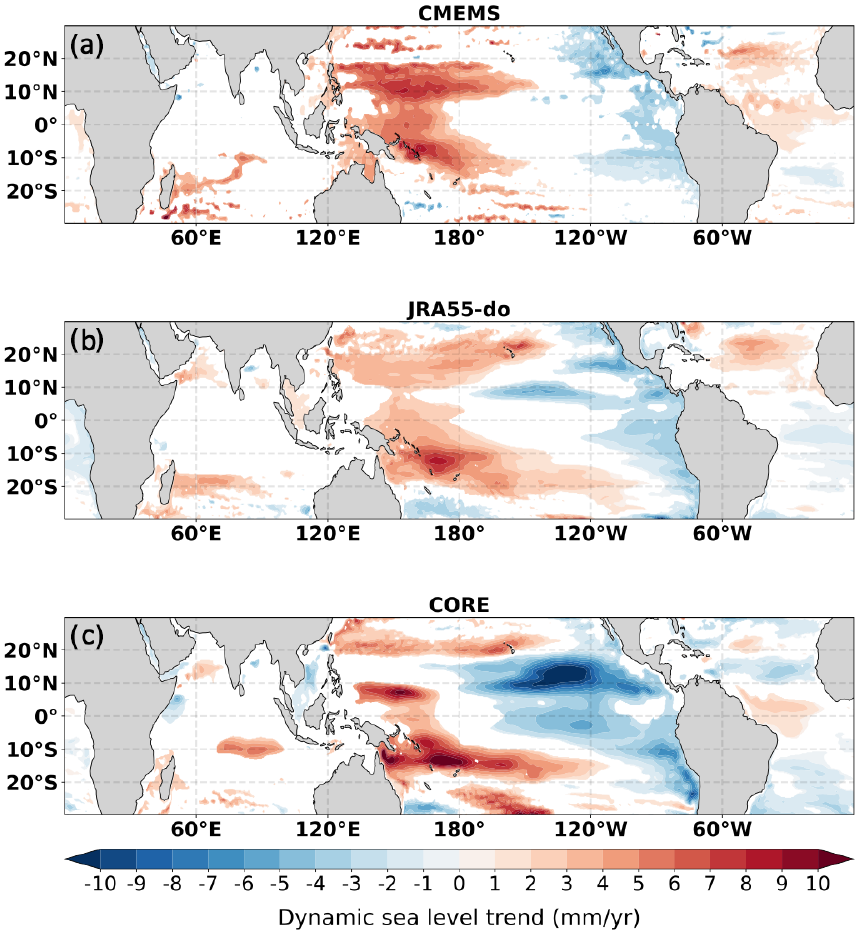
Figure 8. The linear DSL trend during the 1993–2007 period derived from (a) satellite altimeter observation (CMEMS), (b) the JRA55- do-forced simulation, and (c) the CORE-forced simulation. The shaded color shows the trend that is statistically significant with 99%